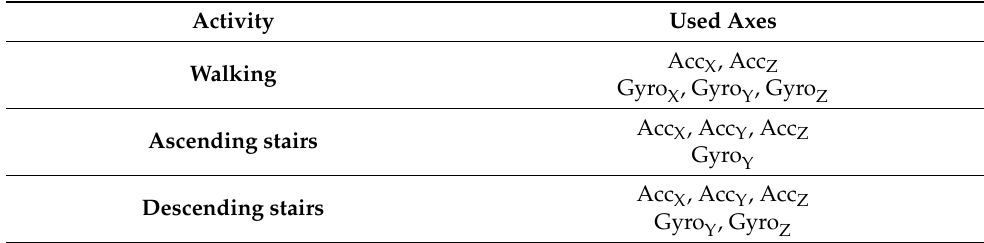
Table 2. Used axes for the selected